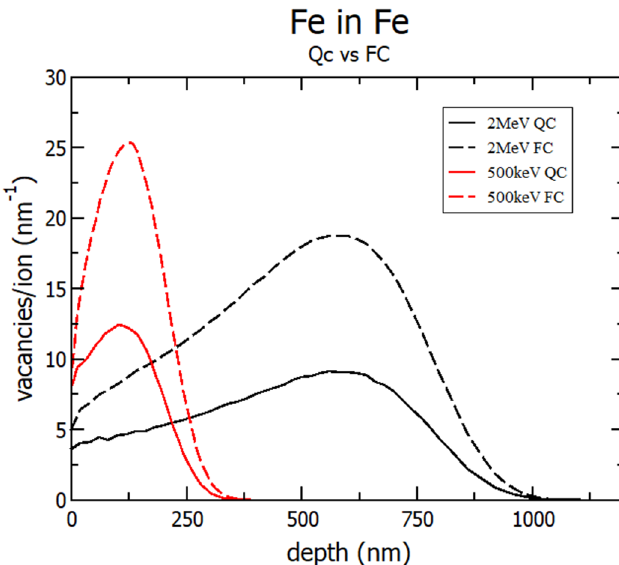
Fig. 3. Damage pro fi les for 2 MeV and 500 keV self-irradiation in iron calculated with Iradina for quick calculation (solid lines) and full cascade (dashed lines).